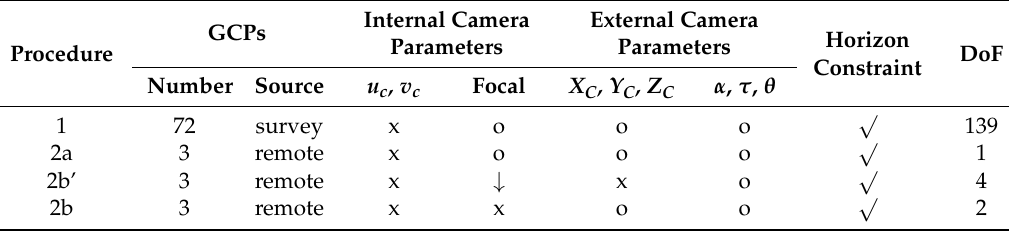
Table 2. Details of the procedures used by C-Pro for the computations. The symbol x indicates the parameters considered fixed, while o those values that were refined trough the iterations. All procedures used the horizon constraint. DoF shows the number of degrees of freedom to solve the linear collinearity system.